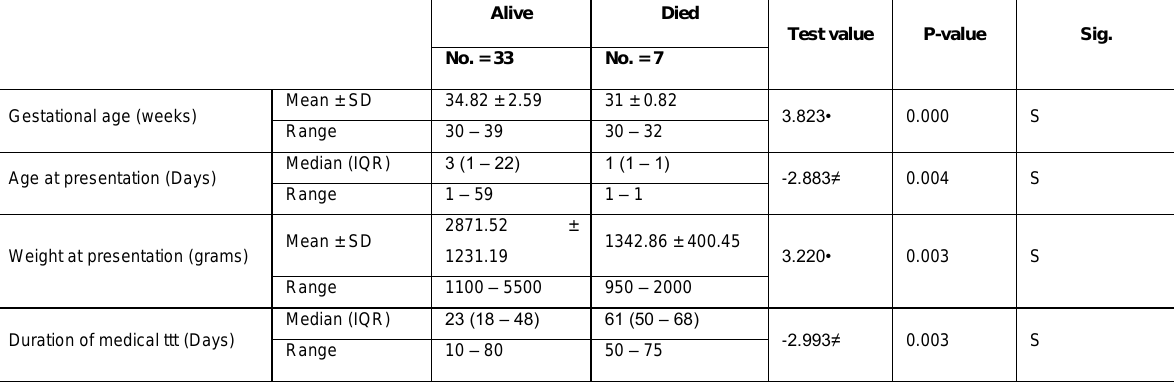
Table 2: The relation between mortality and gestational age, age and weight at presentation, duration of medical